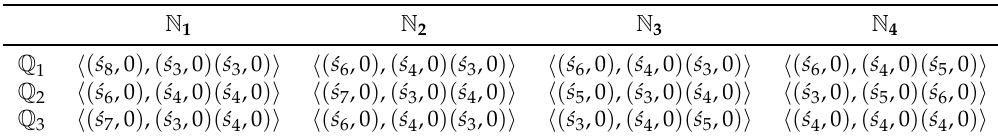
Table 1. 2-tuple spherical fuzzy linguistic decision matrix.